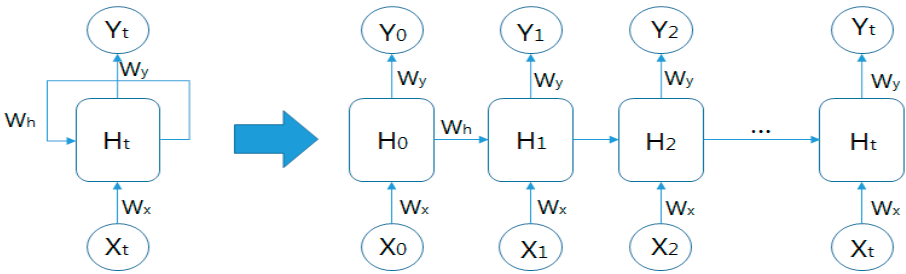
Figure 1. Recurrent Neural Network and unfolding during computation time.